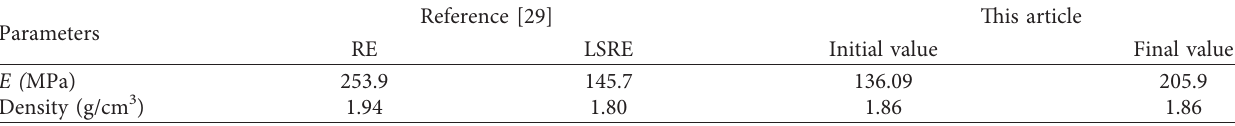
Table 6: Comparison of the parameters between the